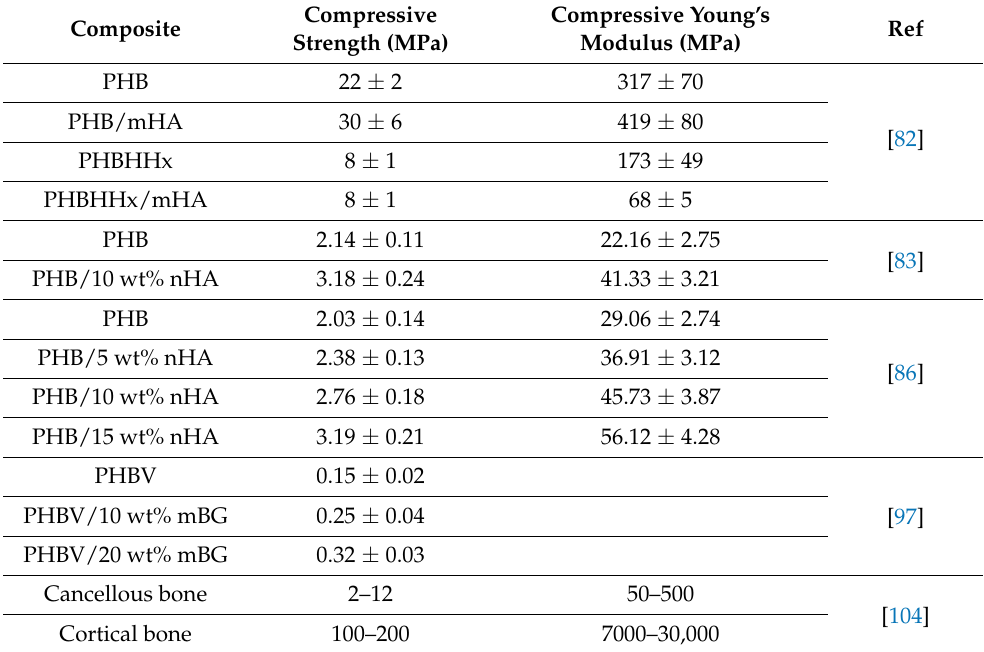
Table 2. Compressive mechanical properties of the PHA-based